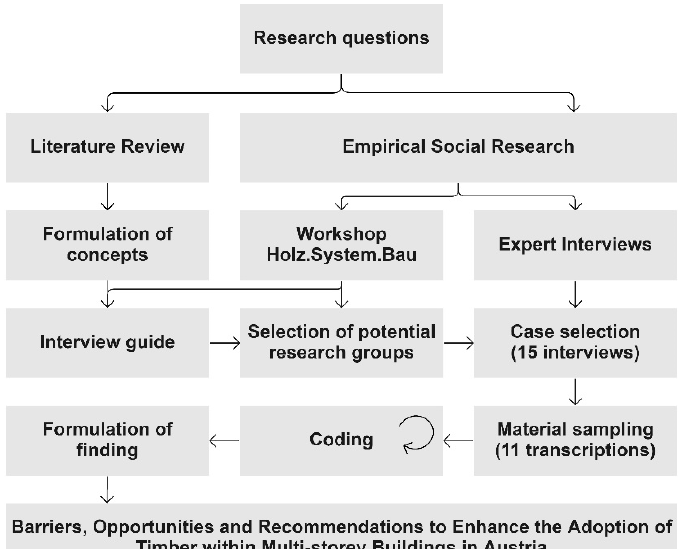
Figure 1. Research design and methodical